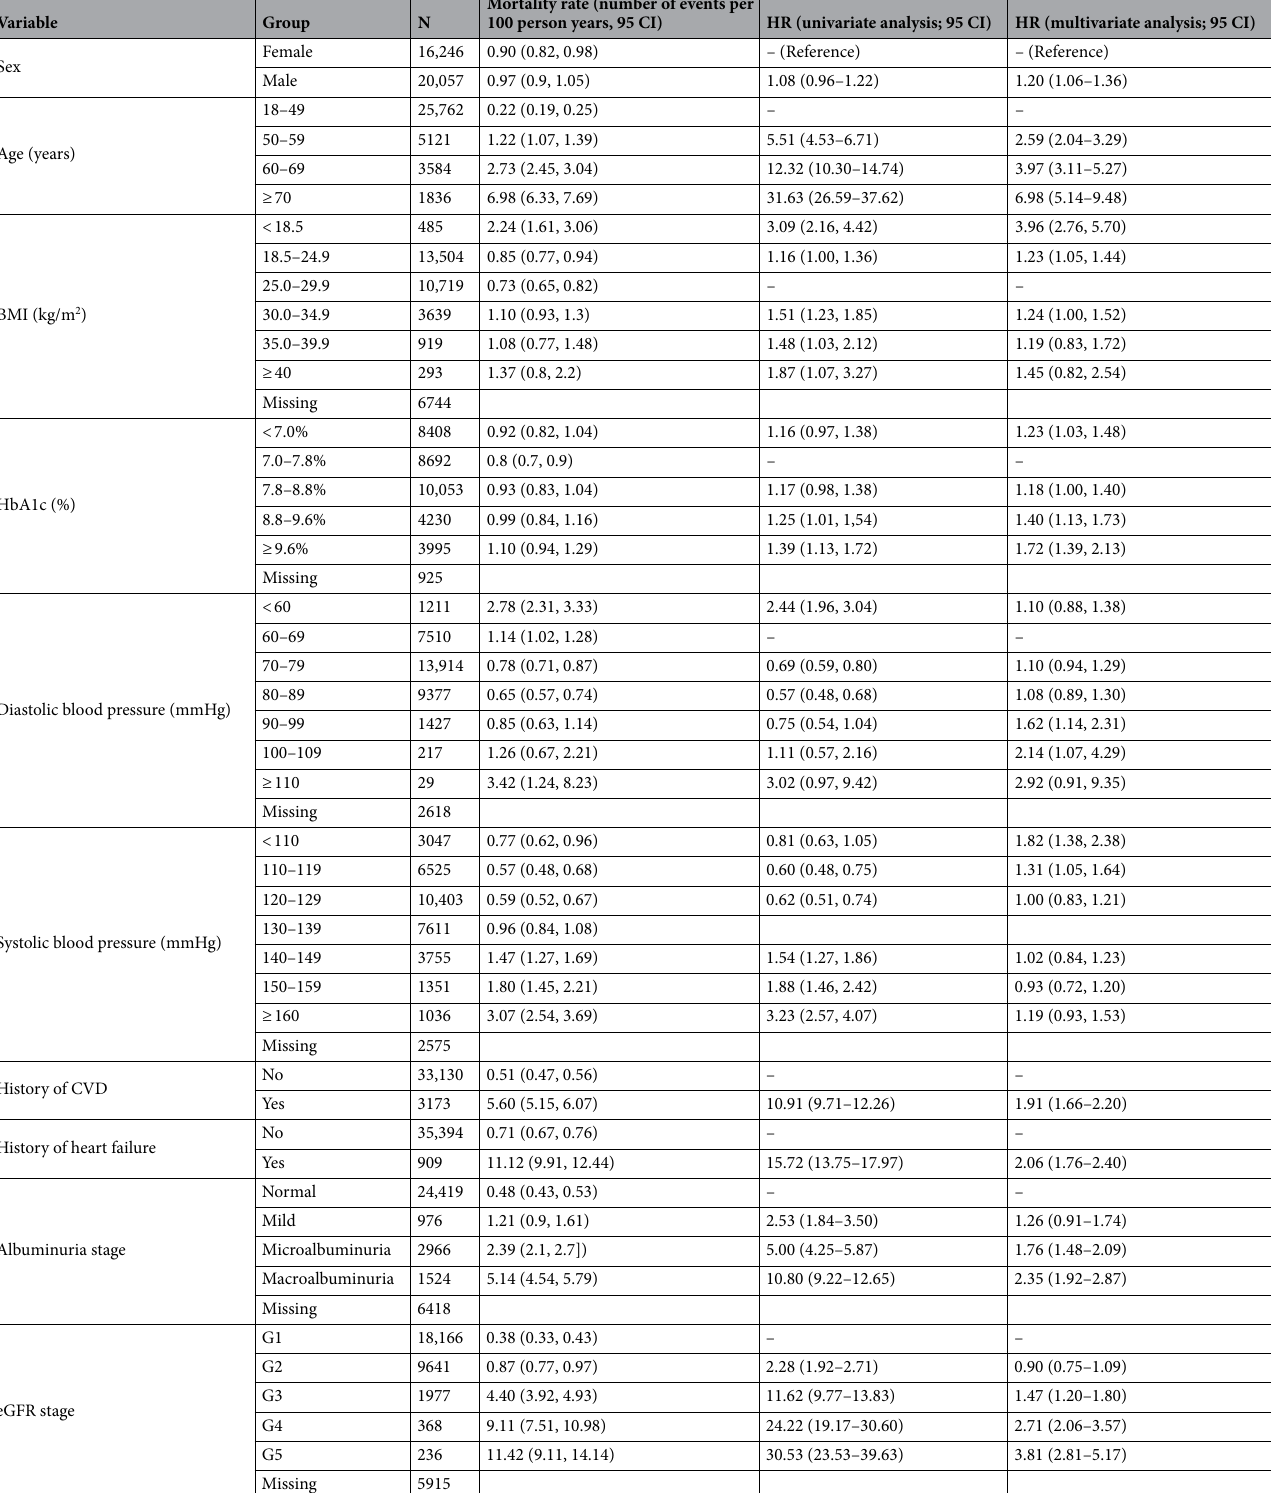
Table 2. Mortality rates and risk according to risk factors and risk group, unadjusted and adjusted (Cox regression). *Denotes the reference